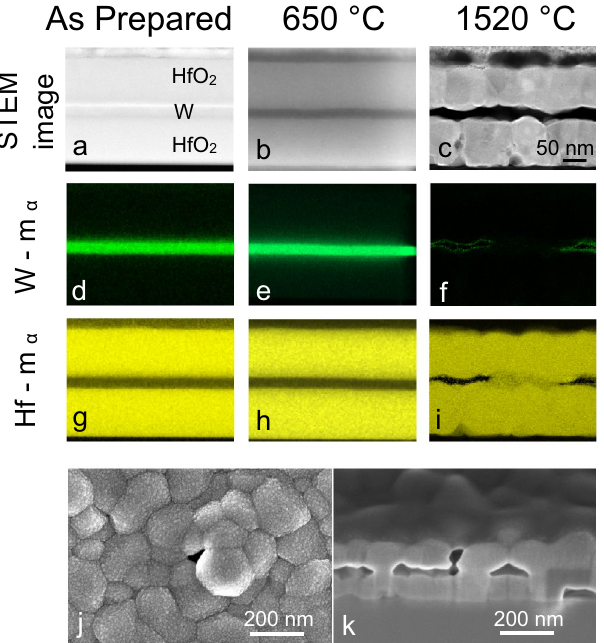
Figure 6. STEM-EDS analysis of the 3-layer-system, as-prepared, annealed at 650 °C and 1520 °C for 6 h. ( a – c ) STEM-HAADF images, ( d – f ) W-Mα elemental mapping, ( g – i ) Hf-Mα elemental mapping. These images have the same scale as indicated in image ( c ). SEM images of the 3-layer-system annealed at 1520 °C for 40 h: ( j ) morphology of the top HfO 2 layer with a void in the middle and ( k ) cross section view along the interfaces across the same void (FIB